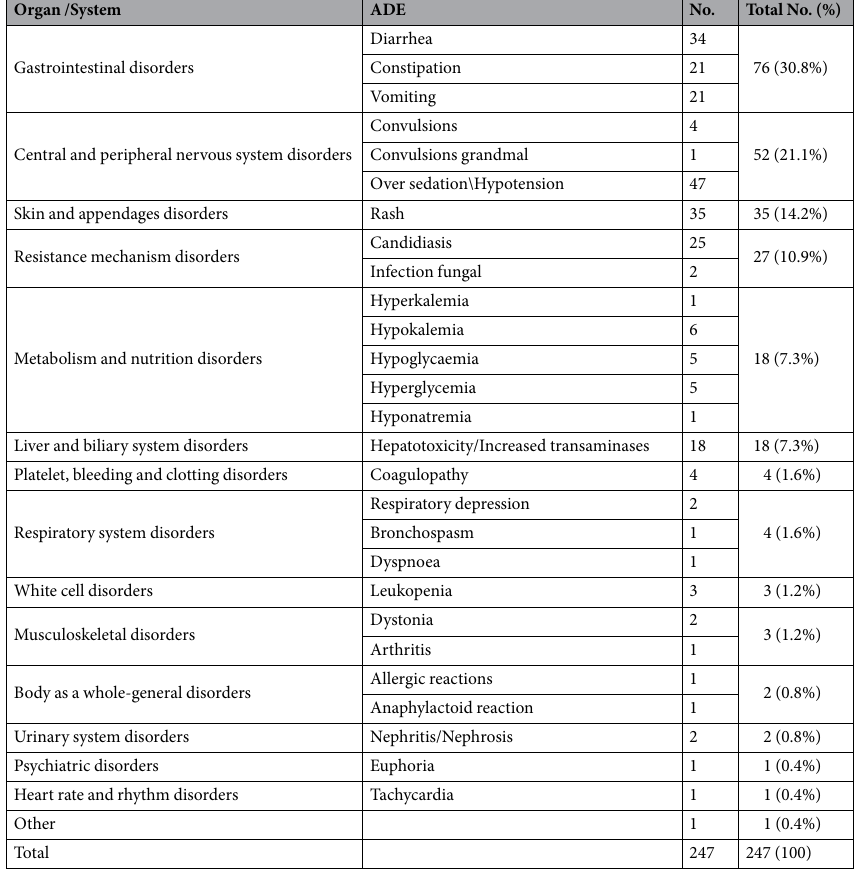
Table 3. 247 cases of ADEs Classes.